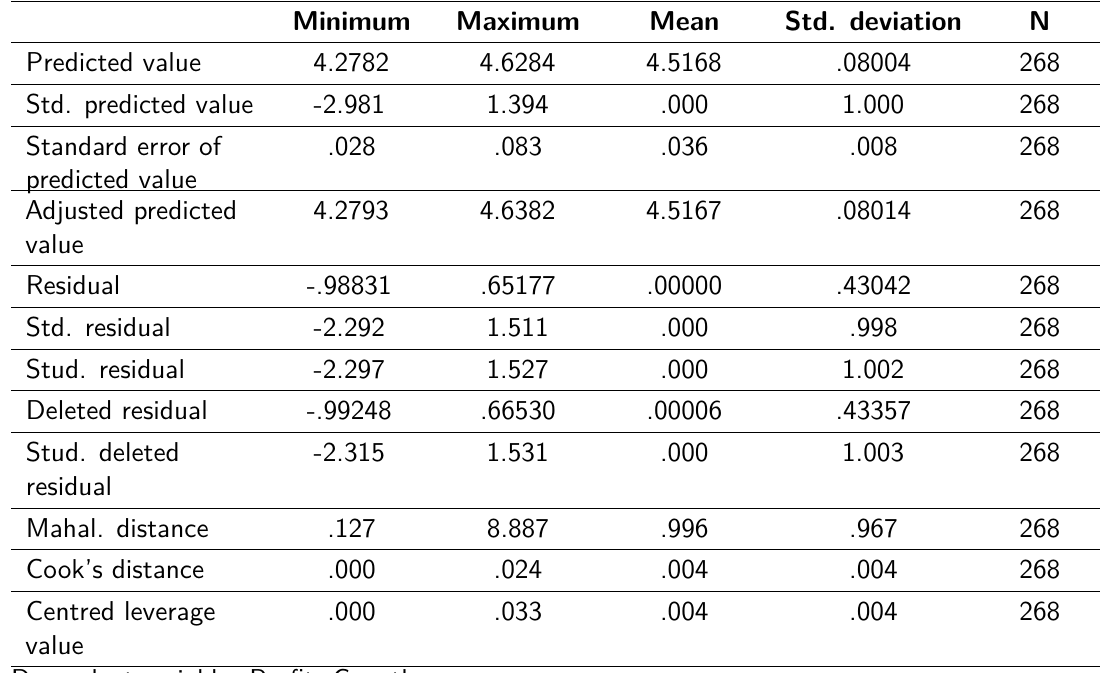
Table 4. Residuals statistics (profit growth) Minimum Std. predicted